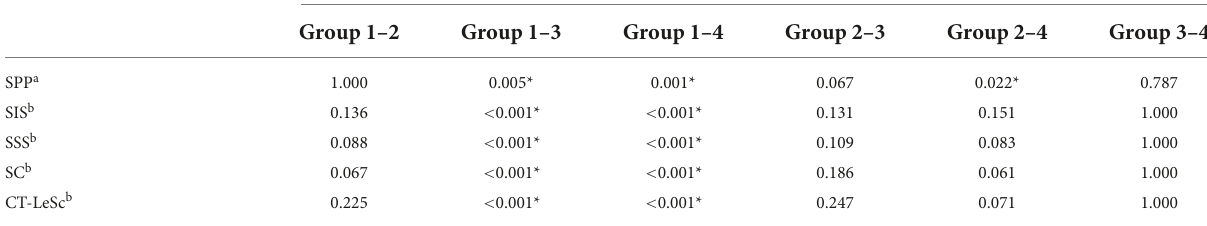
TABLE 8 Post hoc multiple comparisons among the CHD risk subgroups and the control group. Coronary stenosis